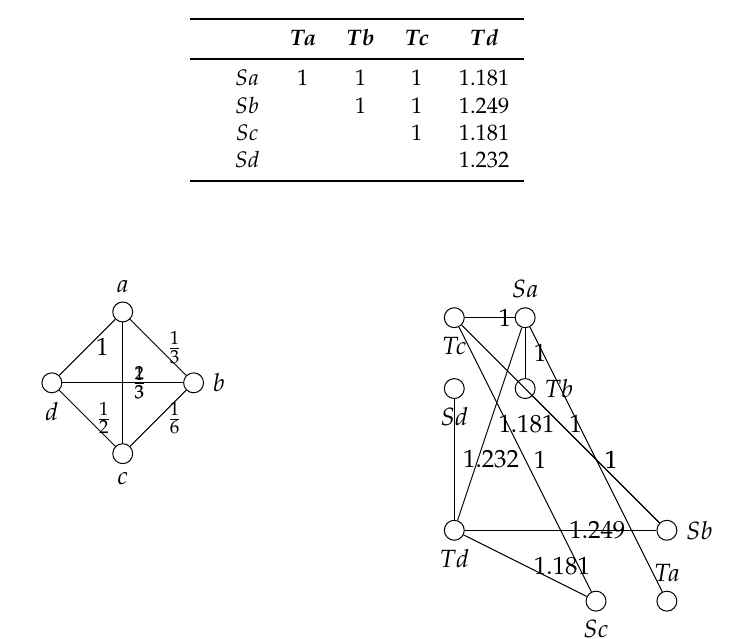
Table 2. A metric indicated by distances between images of vertices under ξ -contractions.